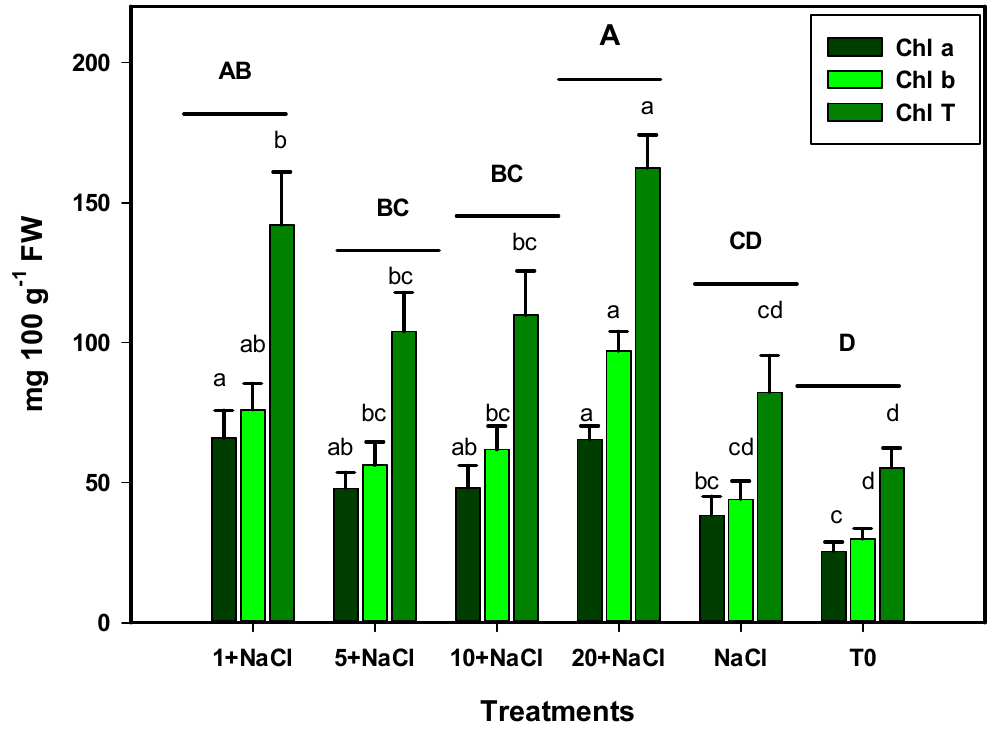
Table 2. MANOVAs of different variables of leaves and fruits of tomato plants under NaCl stress and an application of Se NPs.